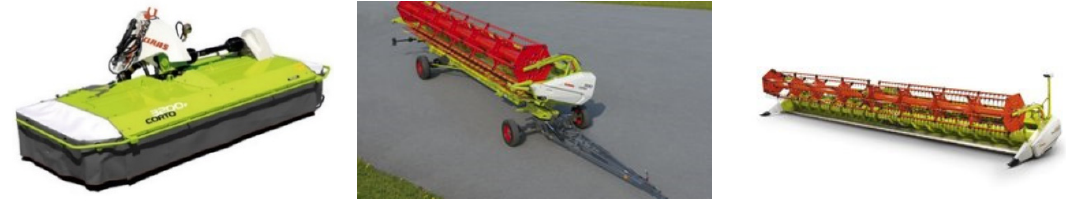
Figure 1. Sample of devices manufactured at the subsidiary company subject of this study.